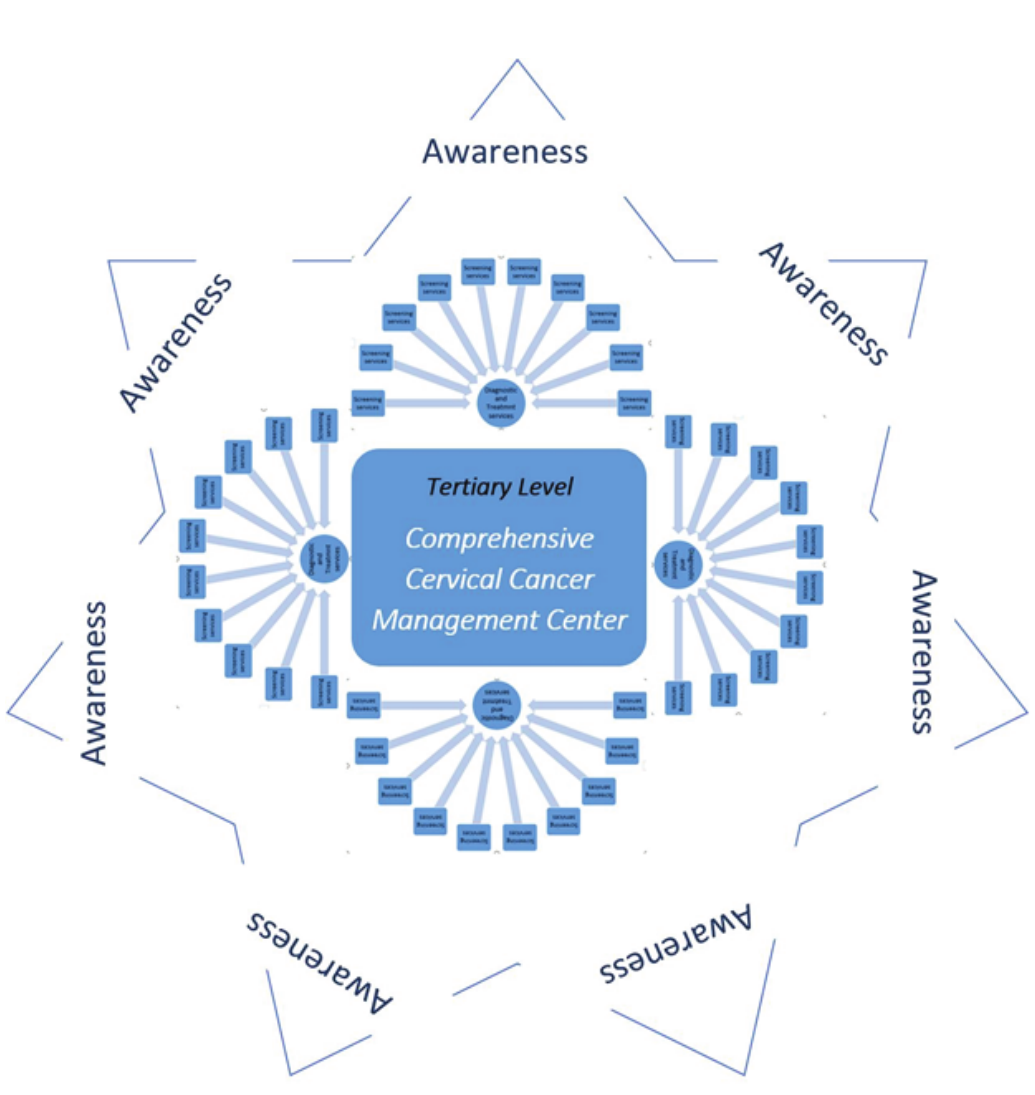
Figure 6: Link between community, primary, secondary-level units and tertiary